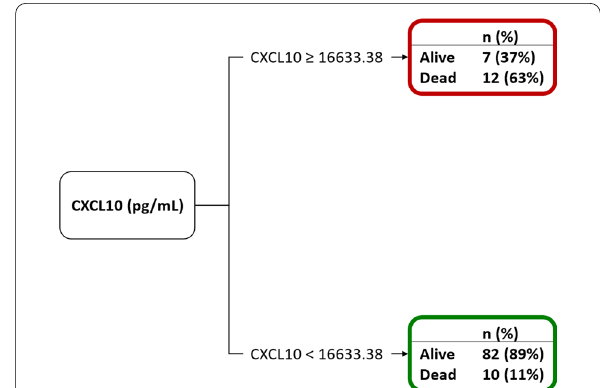
Fig. 3 Decision tree for the prediction of death (AUC [95% CI] 0.7334 [0.7547–0.9201]) =